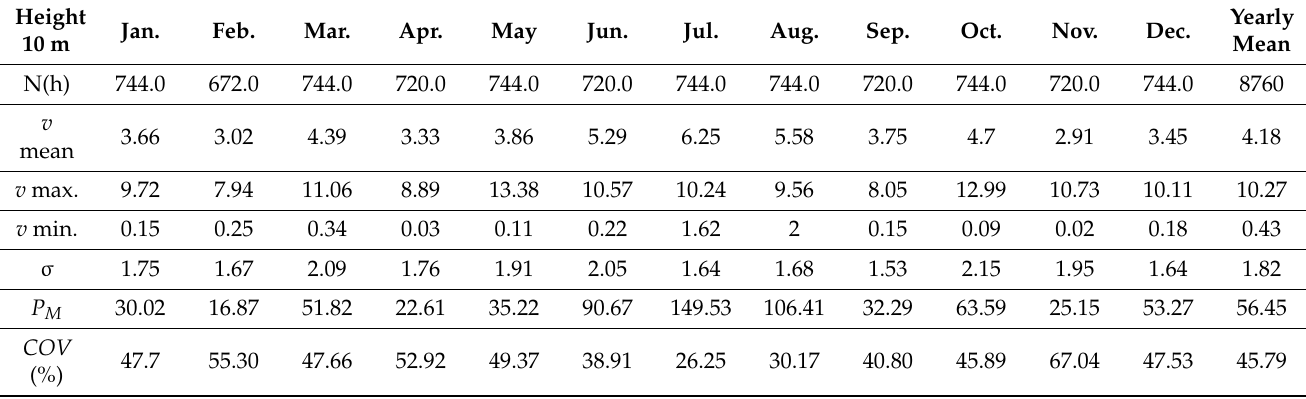
Table 5. The monthly of mean wind speed in (m/s) and ( COV ) coefficient of variation at 10 m height during the period 2018.